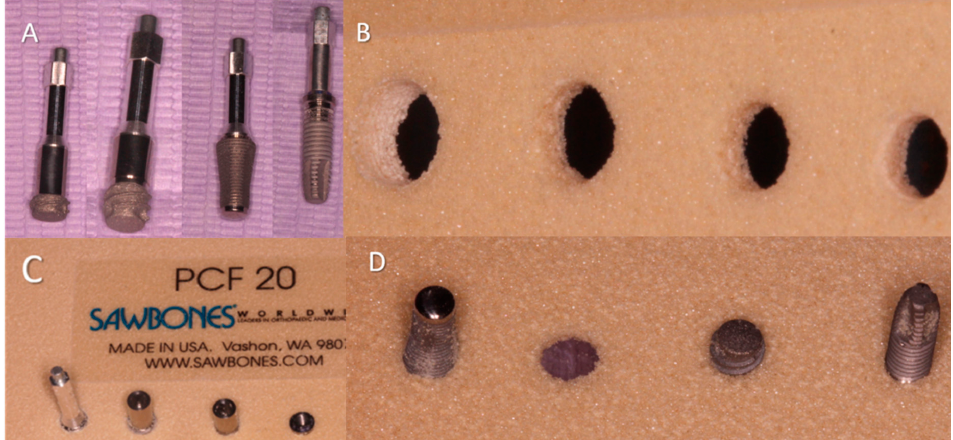
Figure 2. ( A ) From the left to the right: NanoShort 2.5, NanoShort 3.5, self-condenser implant, standard implant; ( B ) details of site preparation of the polyurethane blocks after the drillings protocols; ( C ) implants positioned into a polyurethane block; ( D ) detail of the back view of the positioned